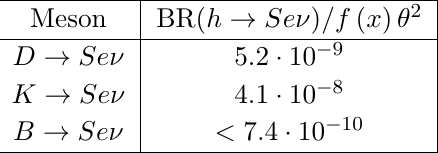
Table 7 . Branching ratios of 3-body meson decay. From experimental data we have only upper